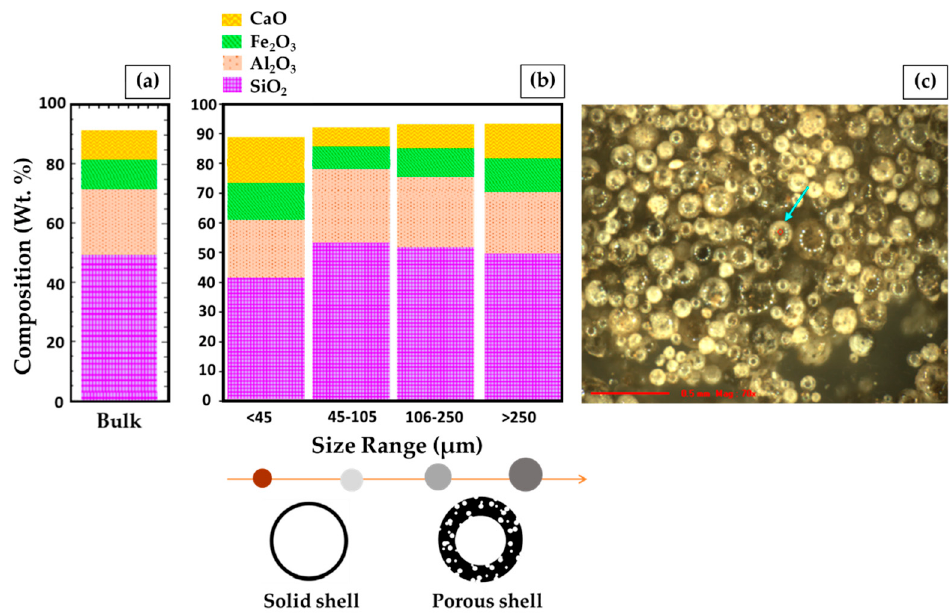
Figure 6. Oxide compositions of the cenospheres plotted in stack columns: ( a ) bulk cenospheres and ( b ) cenospheres after being sieved into different size fractions. The cenospheres were collected by sink-float method, using a fly ash-to-water ratio of 1:10. The data were taken from Table 5. ( c ) X-ray fluorescence (XRF) image of the collected cenospheres of size interval 106–250-µm, the arrow marked is the 150-µm size.